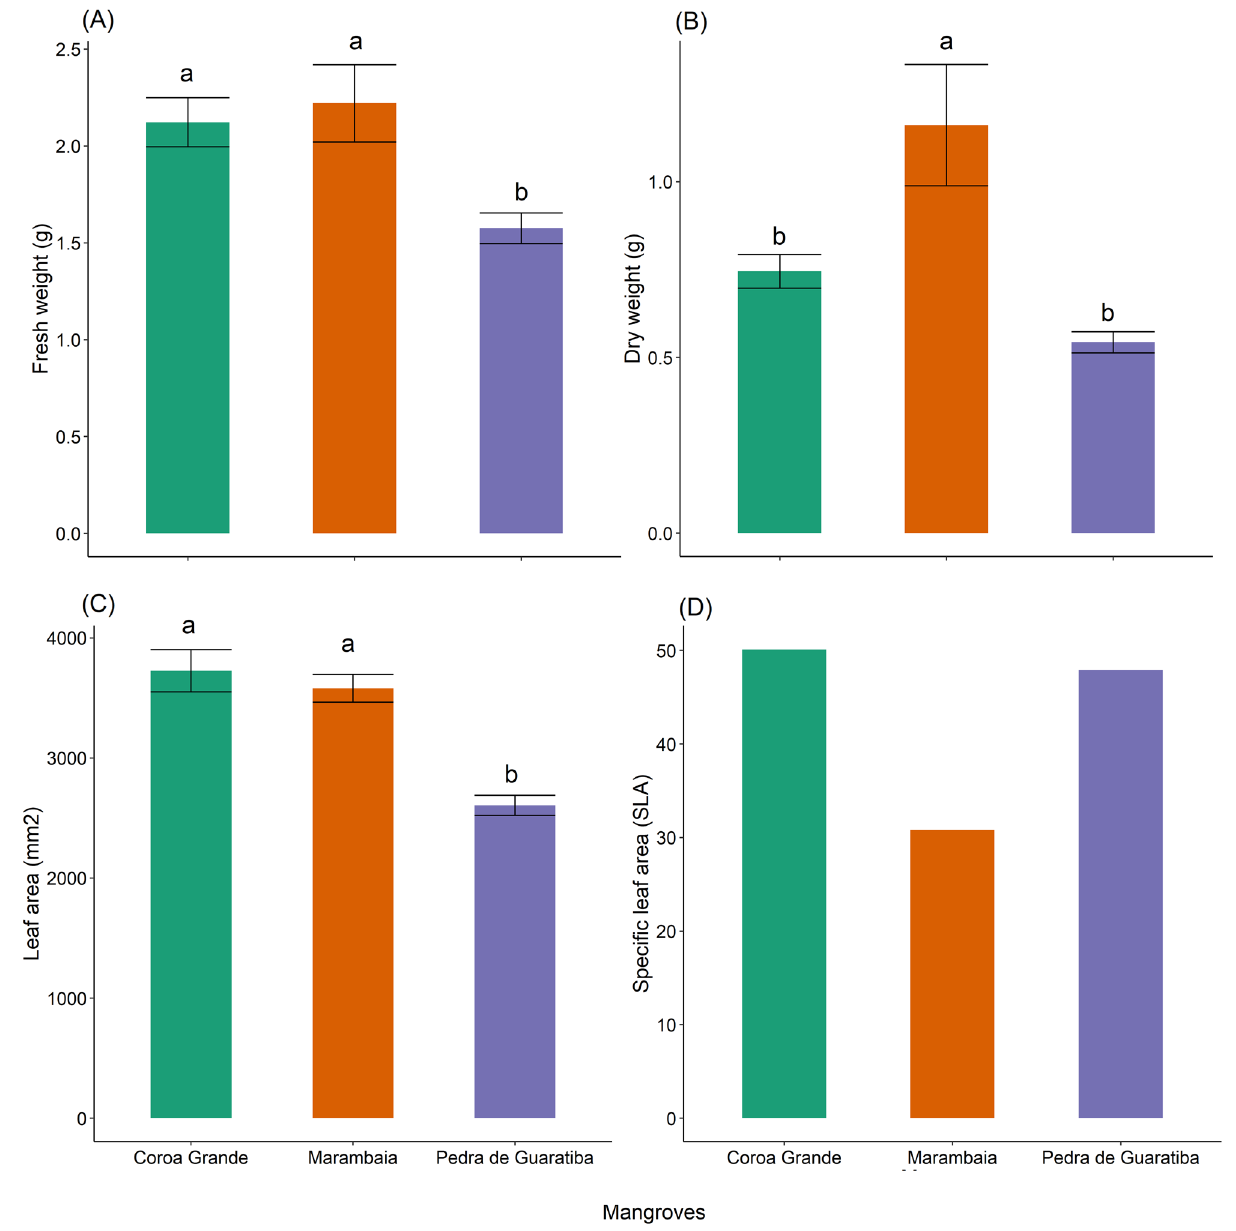
Figure 2. ( A ) Fresh and ( B ) dry weight (g), ( C ) leaf area (LA, mm 2 ) and ( D ) specific leaf area (SLA)